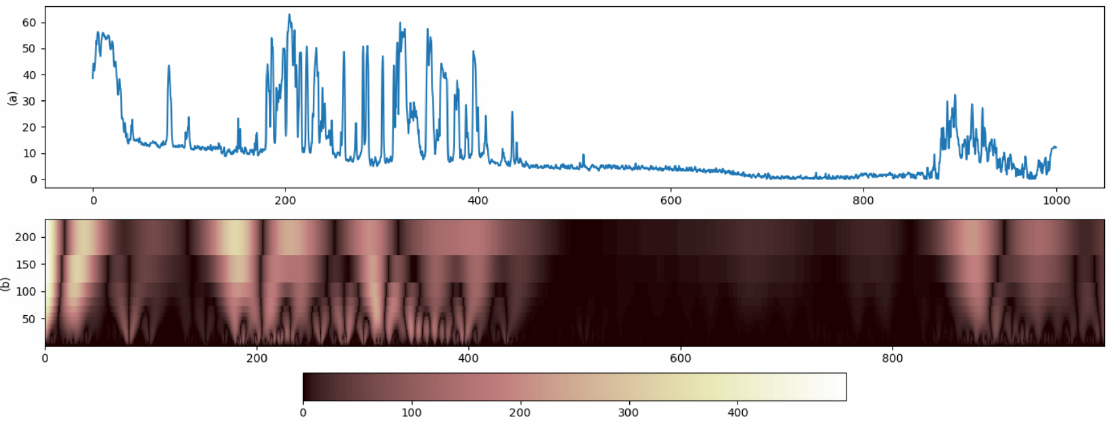
Figure 2. ( a ) SP logging curve ( b ) Time-frequency diagram after wavelet transform. It is clear that the wavelet transform is more sensitive to the logging curve’s abrupt changes and can recognize its singularity with accuracy.